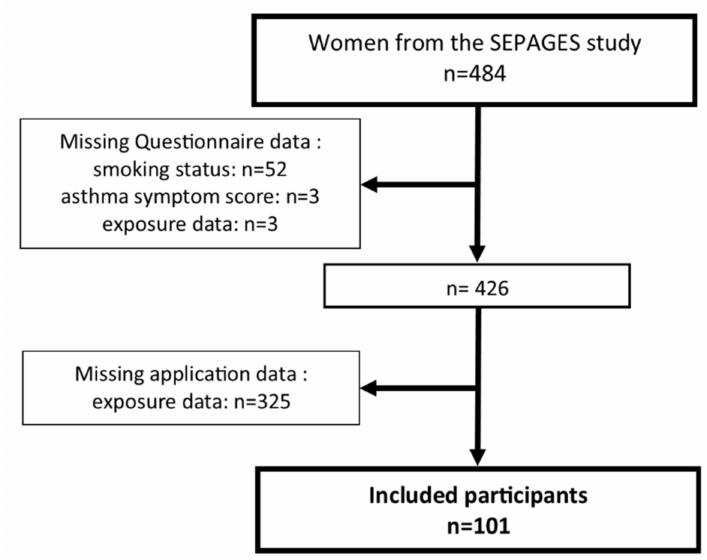
Figure 1. Flowchart for the selected